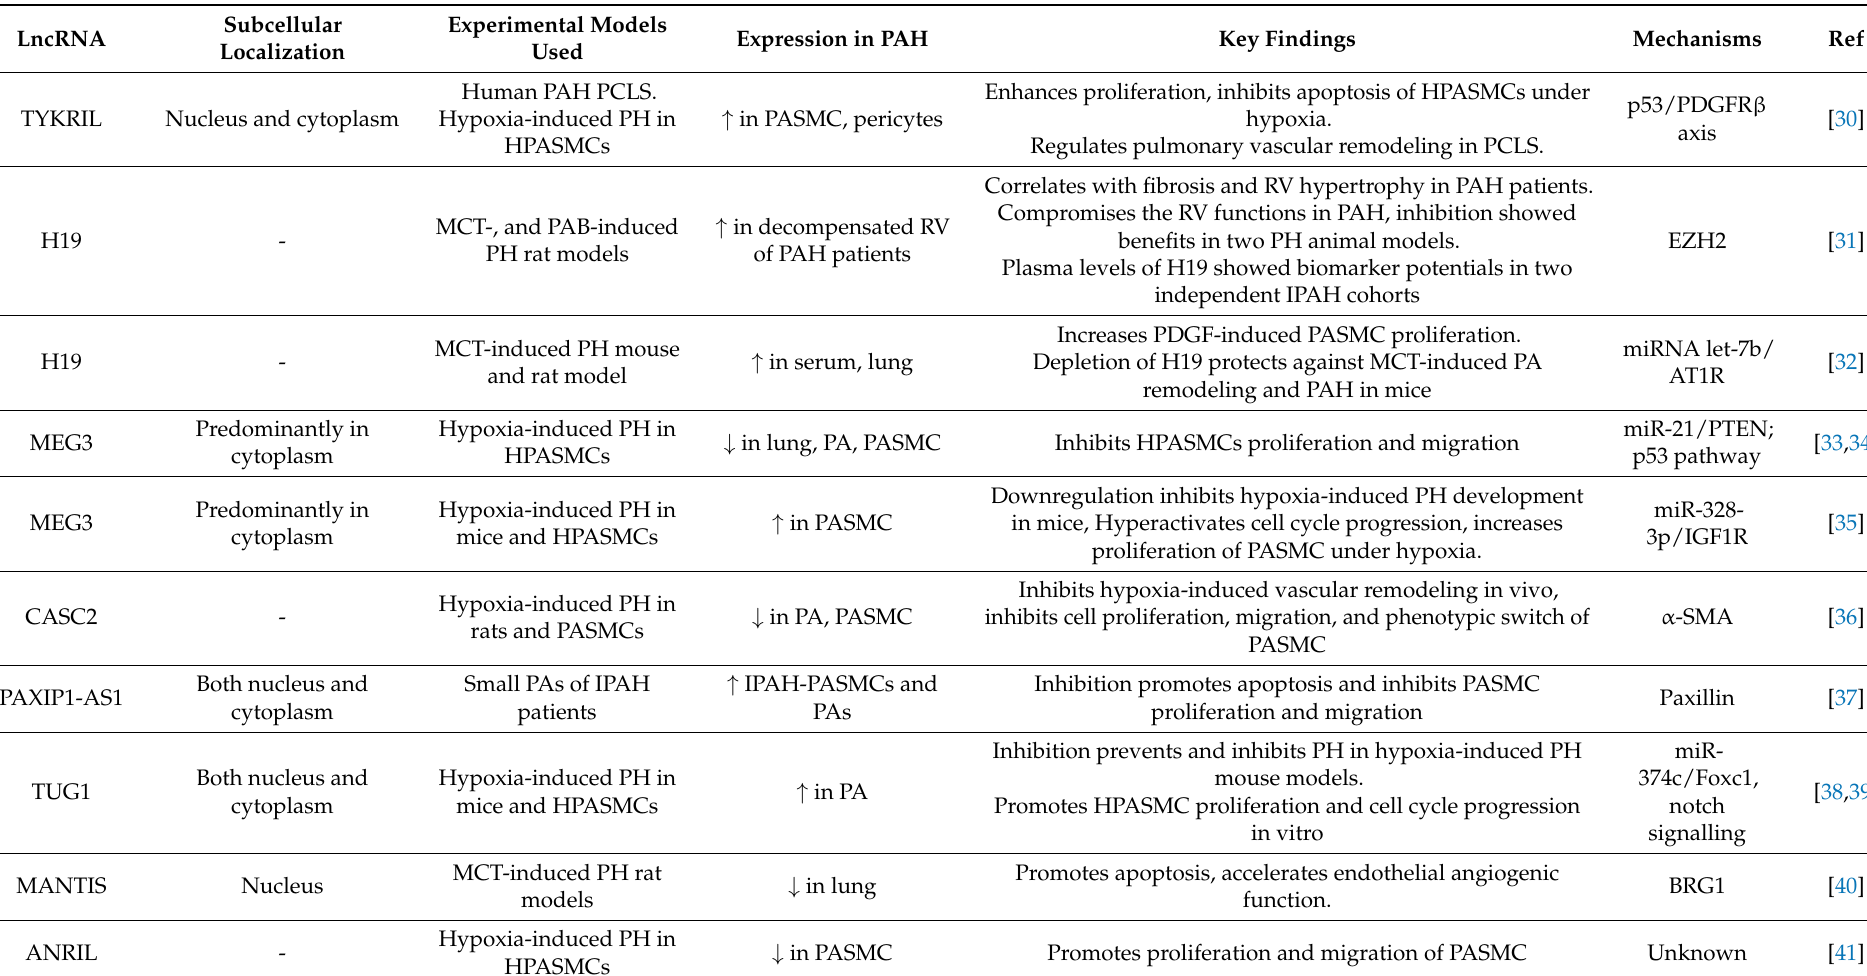
Table 1. Summary of lncRNAs involved in